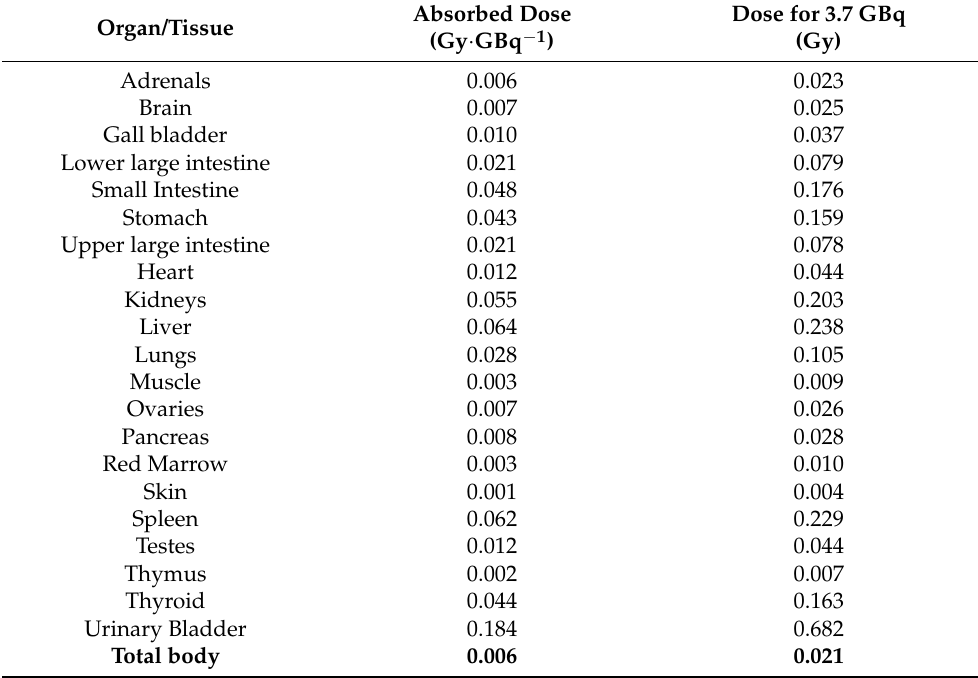
Table 1. Extrapolated [ 131 I]ICF01012 dosimetry for humans: absorbed dose (Gy/MBq) and dose (Gy) for 3.7 GBq extrapolated using Olinda S